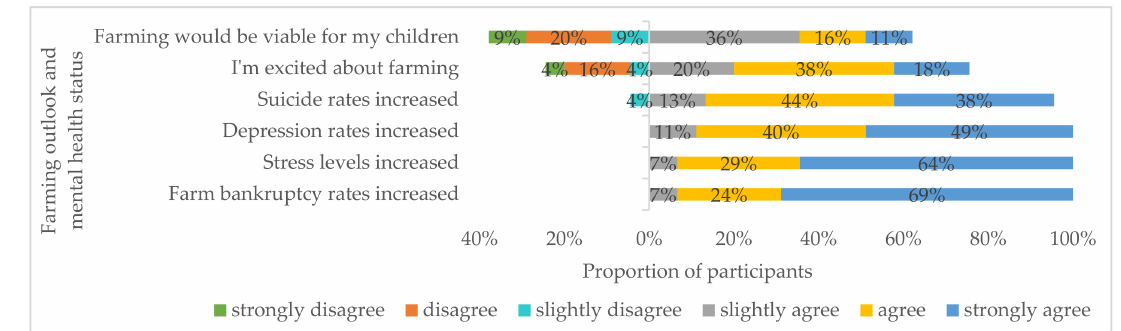
Figure 2. Faming outlook and mental health status among farmers in the past 12 months from participant ranking. The total ranking percentages for suicide (99%) and farming viability (101%) did not add to 100% because of rounding.